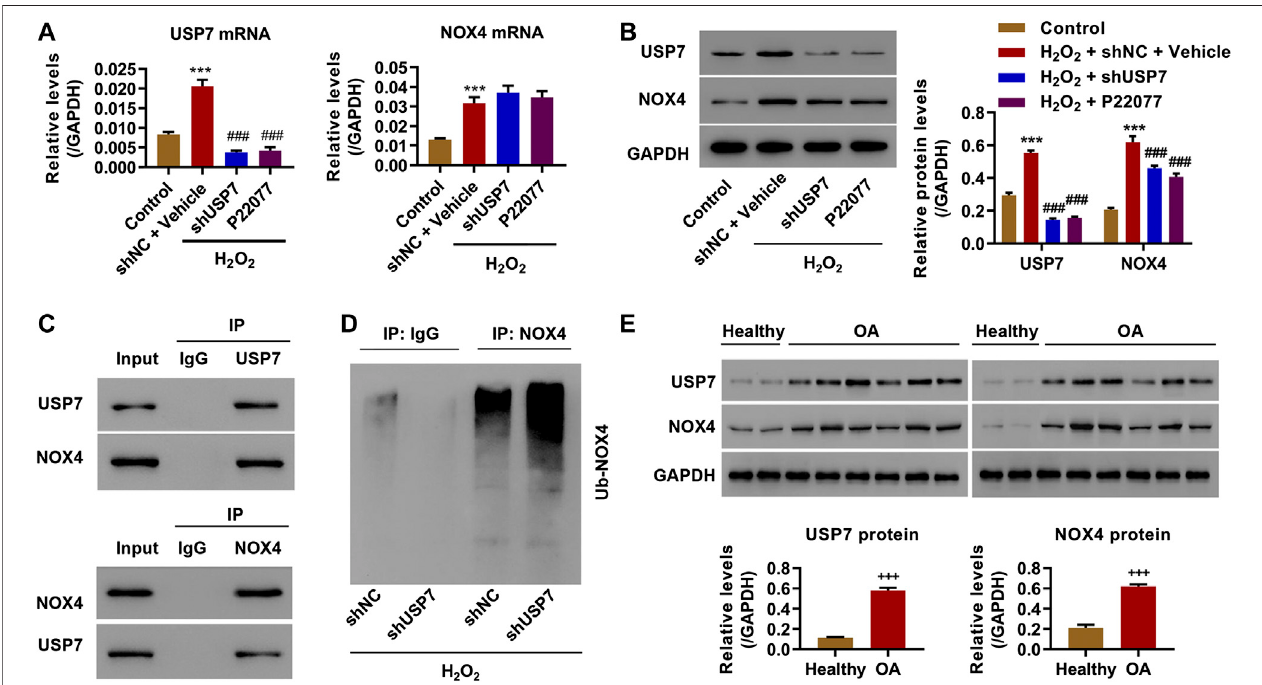
FIGURE4| USP7interactedwithNOX4andinhibitedNOX4ubiquitinylation.Ratchondrocytes weretreatedwith100 μ MH 2 O 2 andtransducedwithUSP7shRNA vector or treated with USP7 inhibitor P22077, and (A) mRNA and (B) protein expression levels of USP7 and NOX4 were measured by qRT-PCR and western blot. (C) Immunoprecipitation was carried out with IgG control, anti-USP7, or anti-NOX4 antibody. (D) USP7-silencing rat chondrocytes were immunoprecipitated with NOX4 or IgG antibodies and ubiquitination was evaluated by Western blot. (E) Expression levels of USP7 and NOX4 in the cartilage of OA patients ( n (cid:2) 12) and healthy controls ( n (cid:2) 4) were measured by qRT-PCR. *** p < 0.001 vs. control; ### p < 0.001 vs. H 2 O 2 + shNC + vector; +++ p < 0.001 vs.